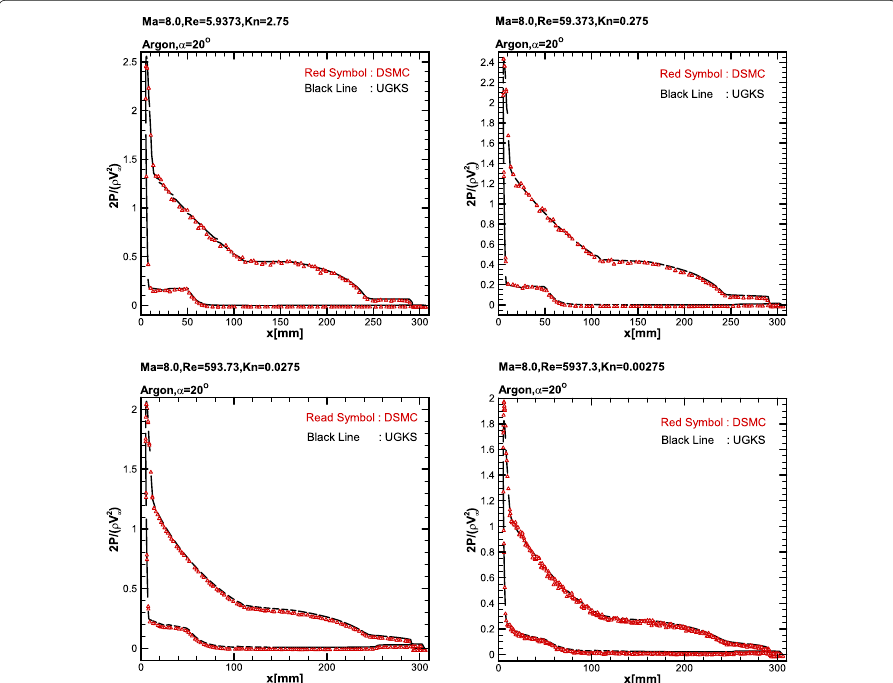
Fig. 5 Comparison of surface pressure distribution. Red symbol: DSMC; Black line: